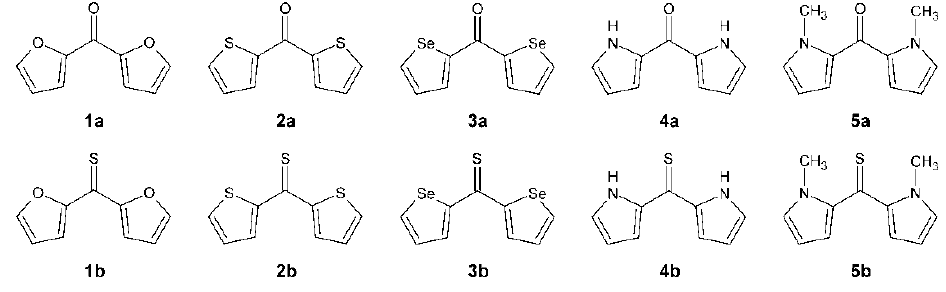
Figure 1. The structural skeletal formulas of 1a – 5a and 1b – 5b .